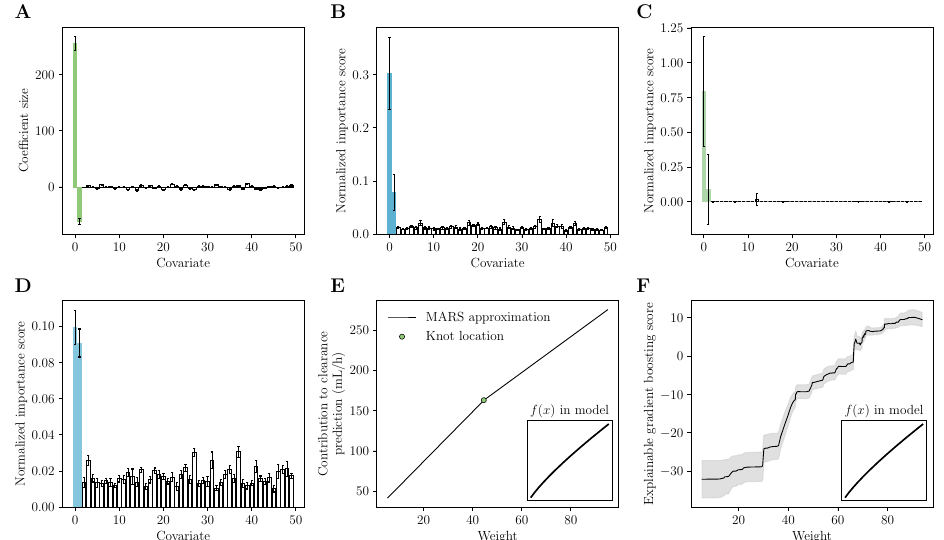
Figure 1. Examples of machine learning-based covariate importance scores. LASSO coefficients ( A ), random forest importance scores ( B ), MARS covariate importance ( C ), explainable gradient boosting scores ( D ), MARS ( E ) and explainable gradient boosting ( F ) approximation of the effect of covariate 1 are shown. Coloured bars indicate true covariates, whereas white bars represent noise covariates. Bar height represents the importance of each covariate. Importance should be larger for true covariates than for noise covariates. The resulting scores can for example be used to select covariates eligible for inclusion in a NLME model. Error bars indicate standard deviation of each score following a ten-fold cross validation. In ( E ), the point indicates the piecewise split location (i.e., a knot). In ( F ), shaded area represents the standard deviation of model predictions in the explainable gradient boosting model. Figure inset represents the function used for covariate 1 in the